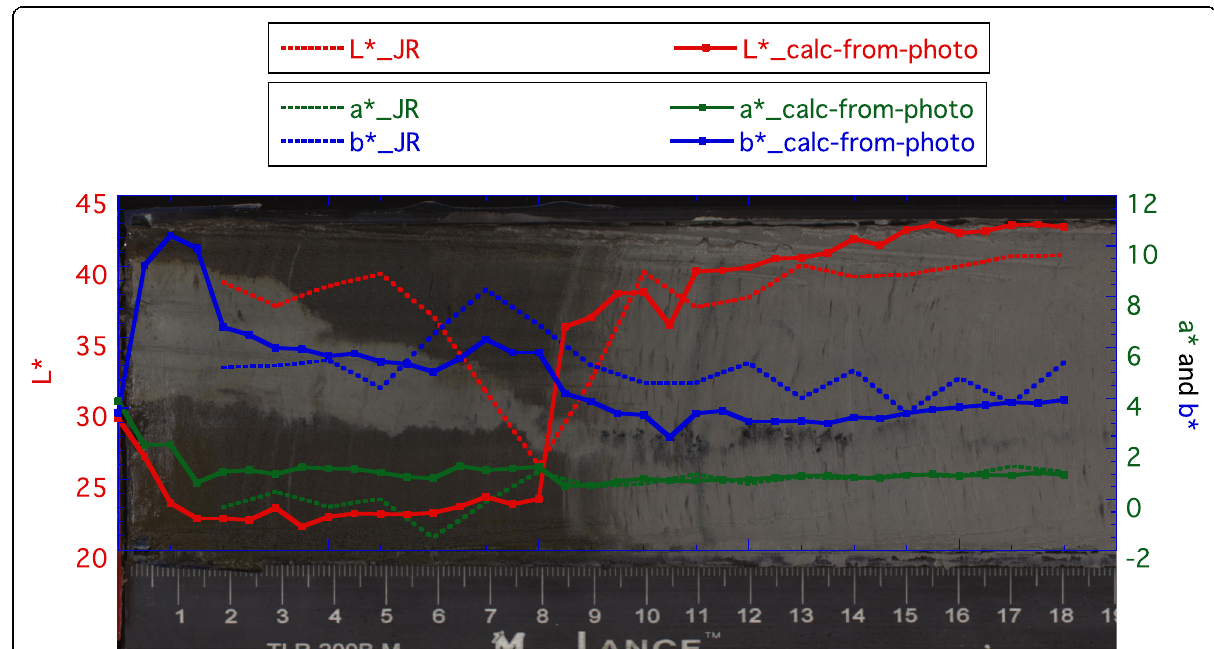
Fig. 5 Example of re-sampling of RGB from section photograph (U1424B-2H-3, top 8 cm) and the calculated